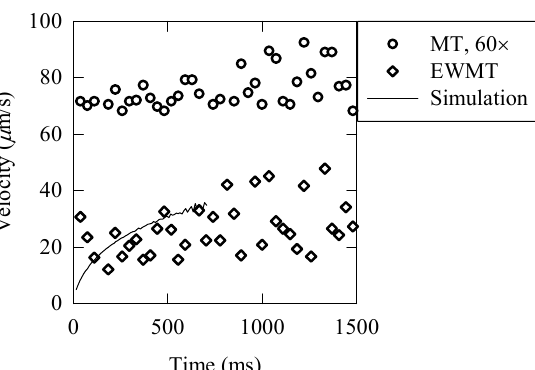
Figure 12. The time evolution of the pressure-driven flow velocity at y = 200 µ m obtained from MT by volume illumination with the 60 × objective lens and EWMT using the CCD camera in comparison with the numerical simulation. Measurement was performed just after 74 ms of the UV laser exposure, thus, for example, 74 ms corresponds to t = t ( t = 74 ms). The centerline velocity was calculated to be 81 µ 0